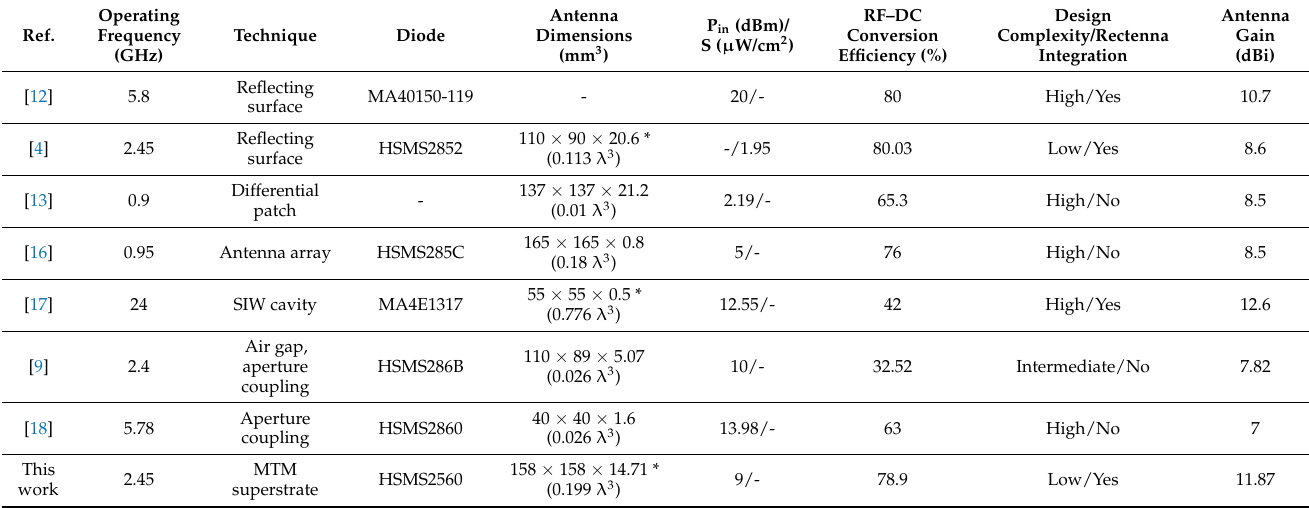
Table 4. Comparison of This Work with Other High-Gain